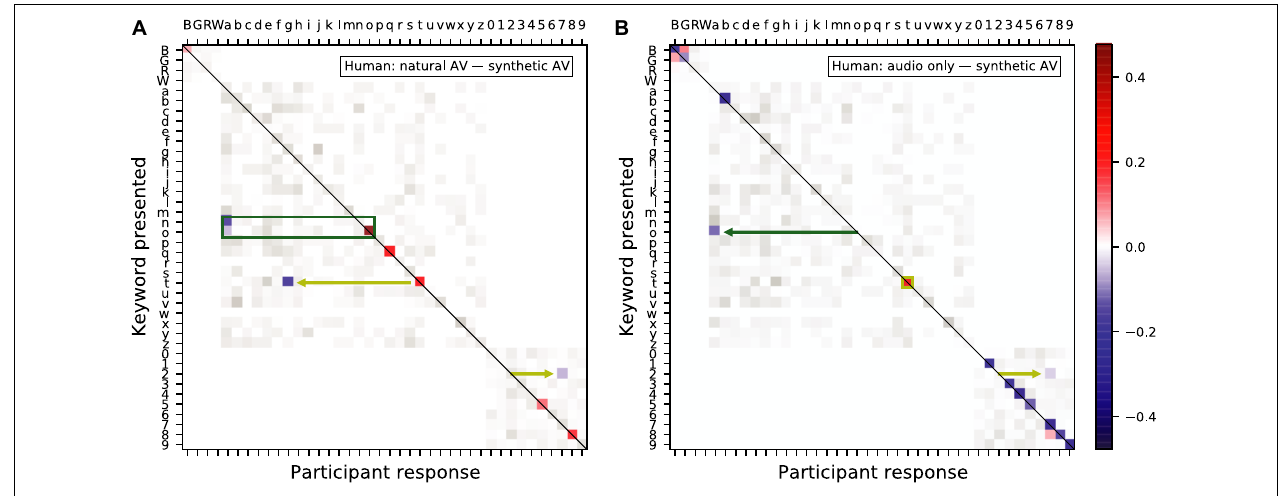
FIGURE 6 | Confusion matrices showing the difference in frequency of presented keyword and participant response pairs between (A) the natural audiovisual condition and the synthesized audiovisual condition and (B) the audio-only condition and the synthesized audiovisual condition, in humans. The color keywords are represented by their first letter in uppercase, those corresponding to a letter are shown in lowercase, and the number keywords by their digit. The magnitude of statistically significant pairs is highlighted in color (bootstrapped permutation test, alpha = 0.05, FDR corrected). A blue color indicates that subjects were significantly more likely to select a particular keyword when being presented with the synthesized visual signal as opposed to (A) the natural video and (B) no video.